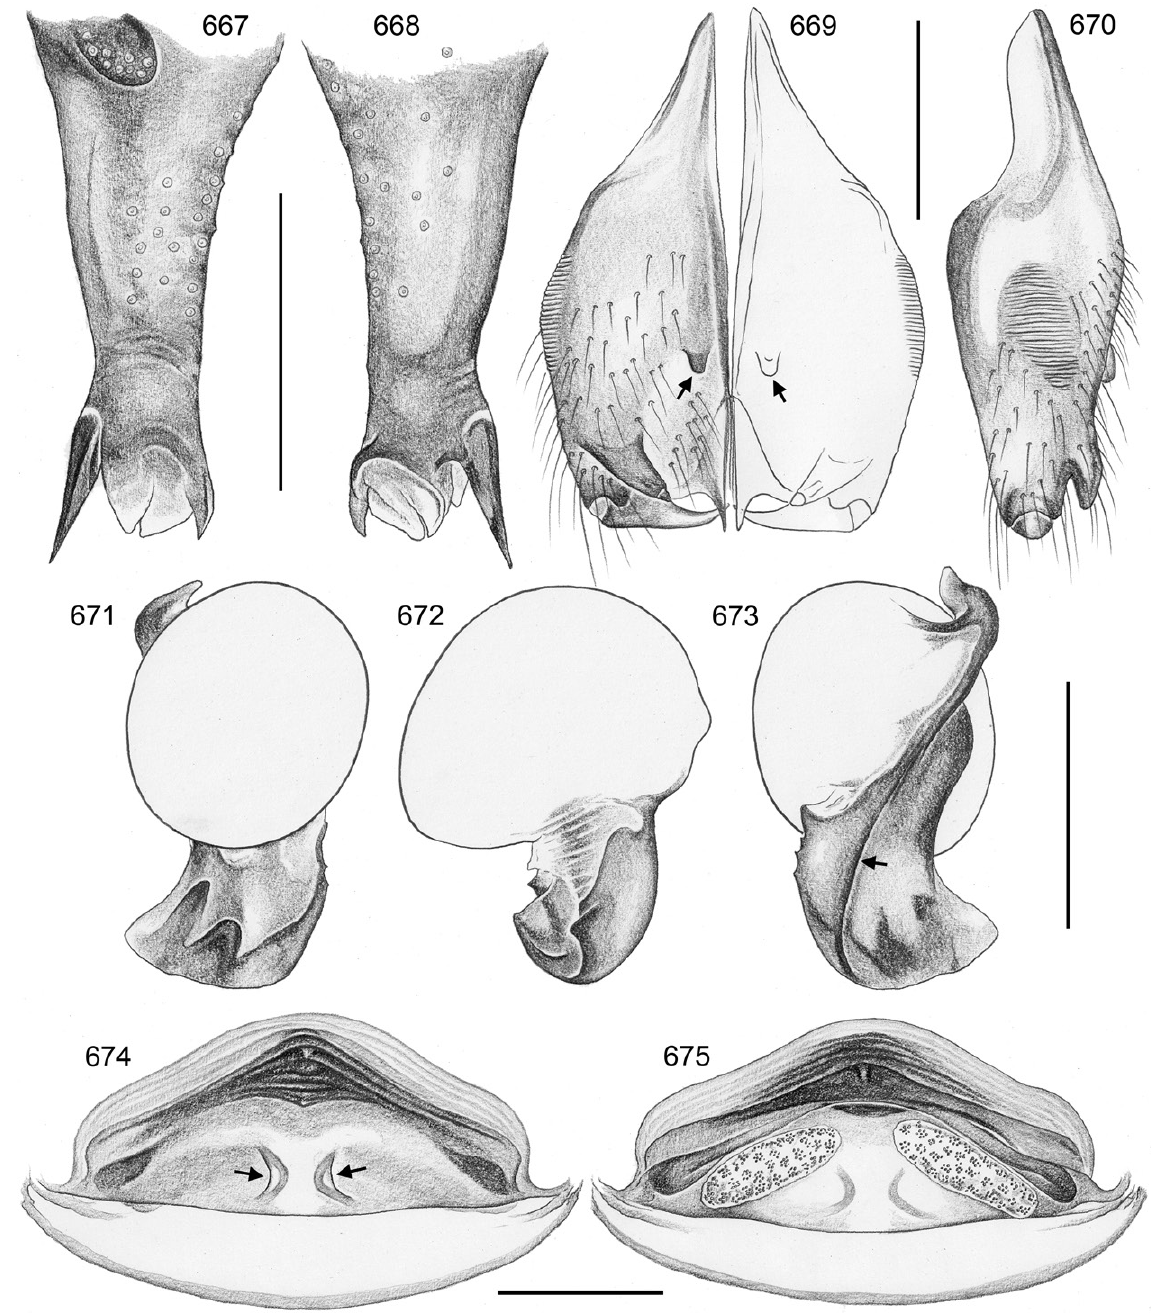
Figs 667–675. Crossopriza kandahar sp. nov.; non-type male and female from Afghanistan, W of Kandahar (MHNG). 667–668 . Left procursus, prolateral and retrolateral views. 669–670 . Male chelicerae, frontal and lateral views; arrows: distinctive pair of apophyses. 671–673 . Left genital bulb, prolateral, dorsal, and retrolateral views; arrow: retrolateral ridge. 674–675 . Cleared female genitalia, ventral and dorsal views; arrows: pockets. Scale bars = 0.3